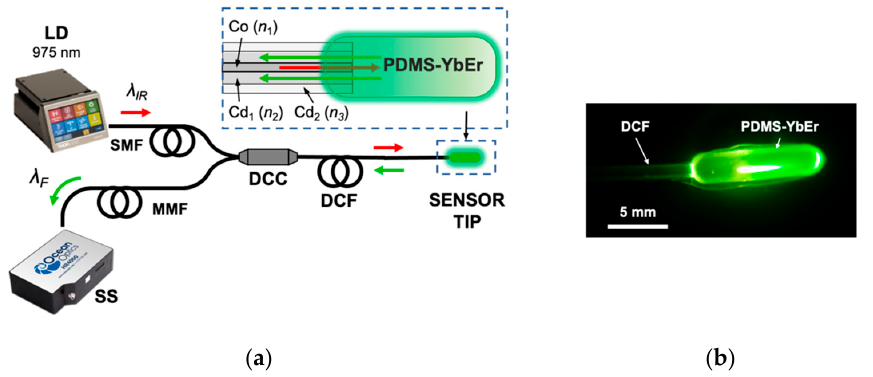
Figure 12. ( a ) Schematic representation of the experimental setup used to test an optical fiber temperature sensor. The sensing tip comprises PDMS-YbEr composite deposited on a double-cladding fiber (DCF). Using a double-cladding coupler (DCC), the fluorescent material is excited with the laser diode (LD, λ IR ), and the fluorescence signal ( λ F ) is analyzed with a solid-state spectrometer (SS). The inset shows the structure of the DCF formed by a central core (Co) and two concentric claddings (Cd 1 and Cd 2 ). See text for further details. ( b ) Image of the sensor tip showing the green UC fluorescence from the PDMS-YbEr composite.